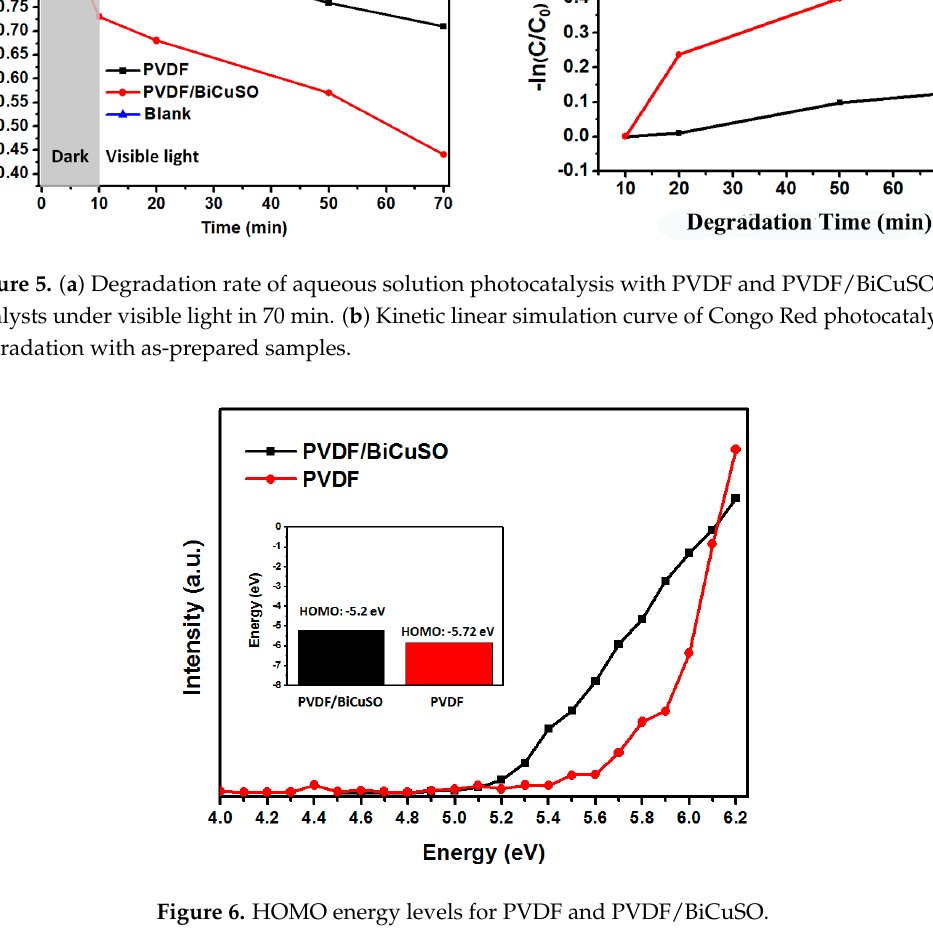
Figure 6. HOMO energy levels for PVDF and PVDF/BiCuSO.